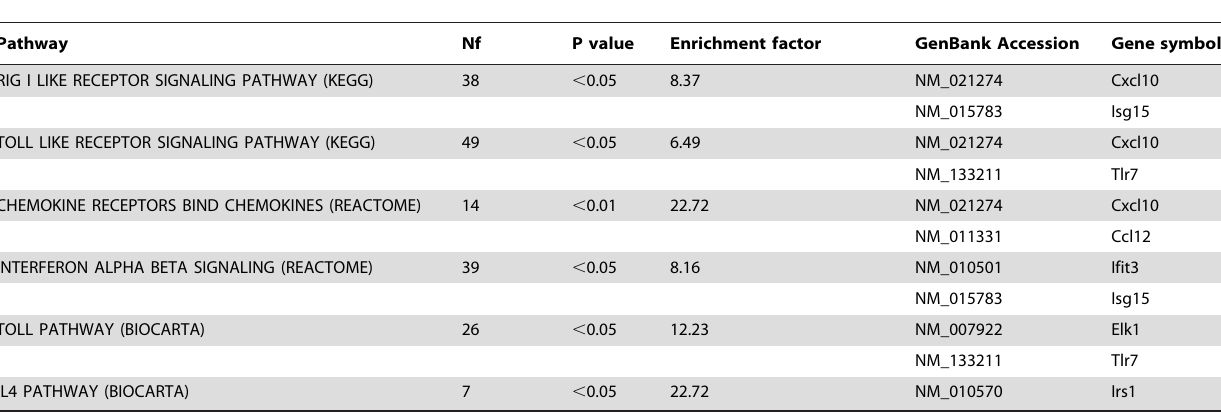
Table 3. Summary of gene set enrichment analysis.